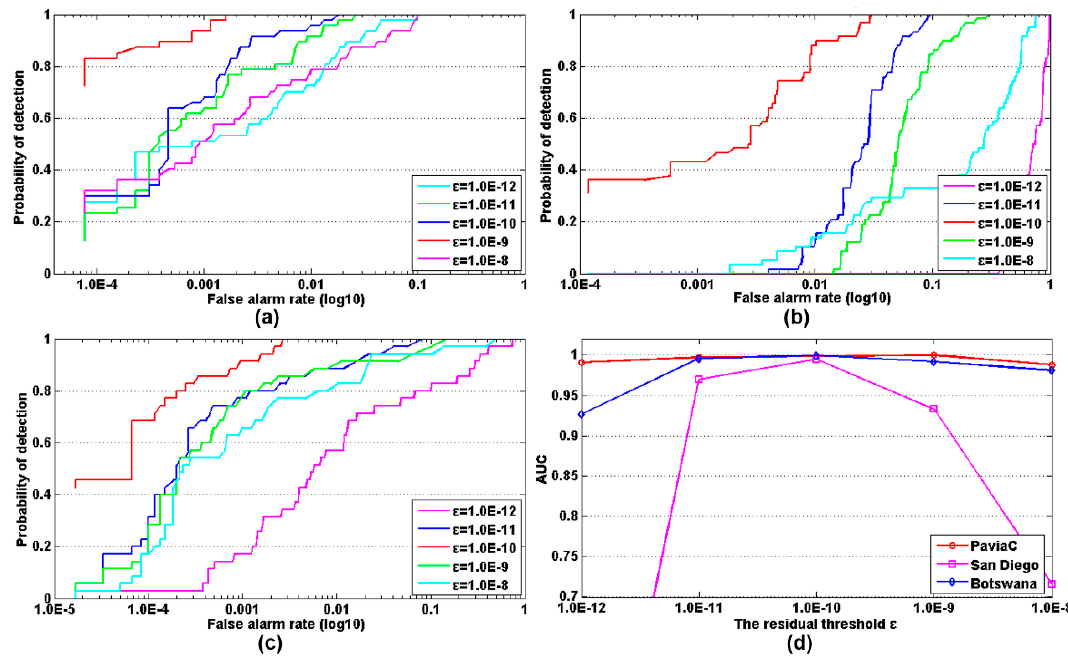
Figure 16. The logarithmic receiver operating characteristic (ROC) curves of RSLAD on: ( a ) PaviaC; ( b ) San Diego; and ( c ) Botswana, with different choices of (d)residual threshold (cid:2013) .